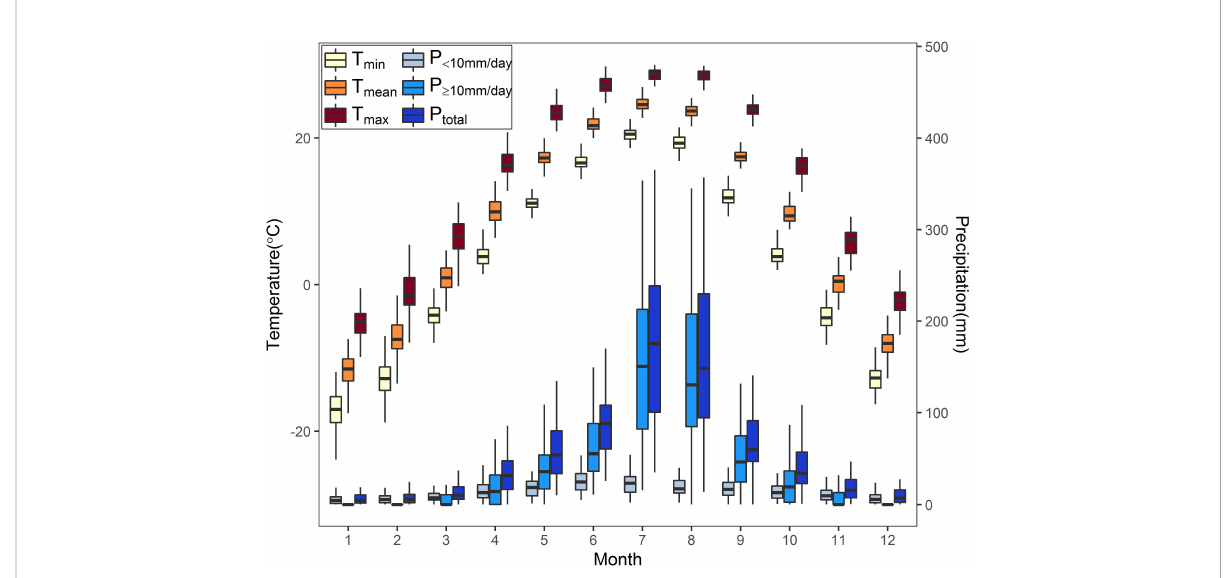
FIGURE 2 Monthly temperature and precipitation indices from January to December in the study area during 1951 – 2020. T min , T mean , and T max represent the monthly averaged minimum, mean, and maximum temperature, respectively. P <10mm/day , P ≥ 10mm/day , and P total represent the monthly total precipitation below 10 mm/day, above or equal to 10 mm/day, and above 0